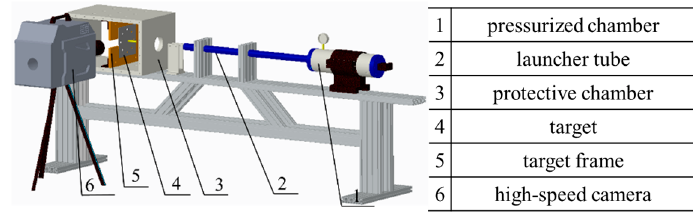
Figure 1. Schematic diagram of one-stage gas gun.